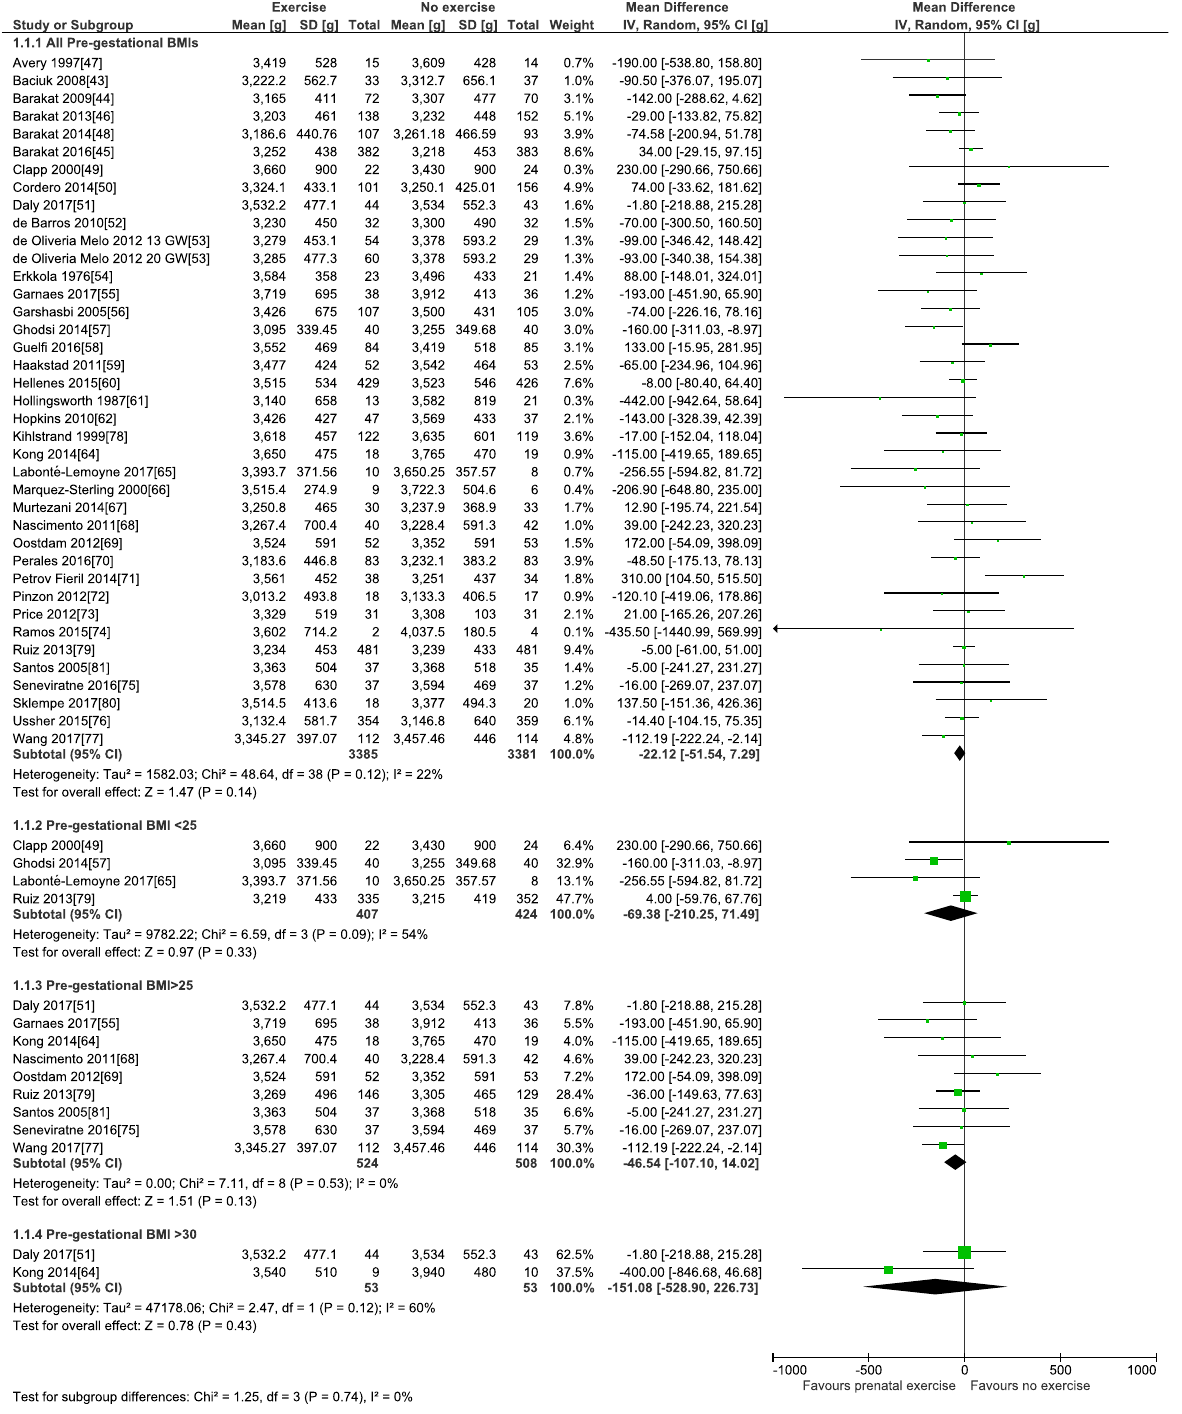
Fig. 2 Forest plot of pooled mean differences for birth weight after exposure to prenatal exercise vs. no